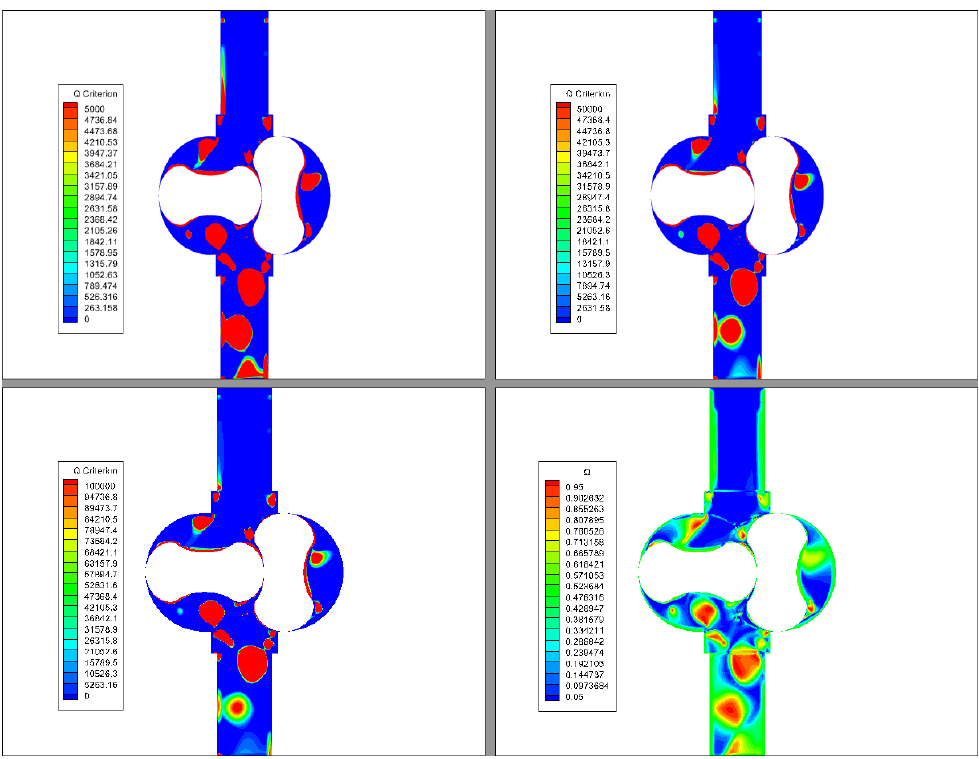
Figure 17. Comparison between Q criterion and omega criterion.